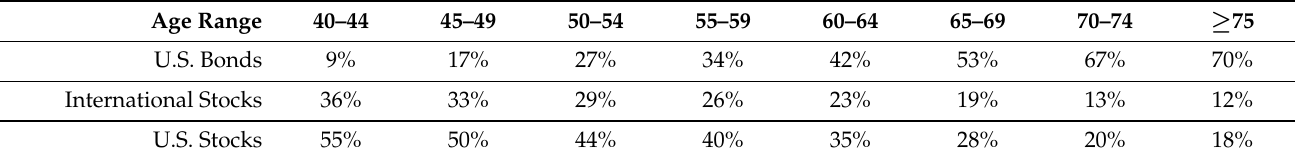
Table 6. The standard glide path strategy used for the target date fund in this